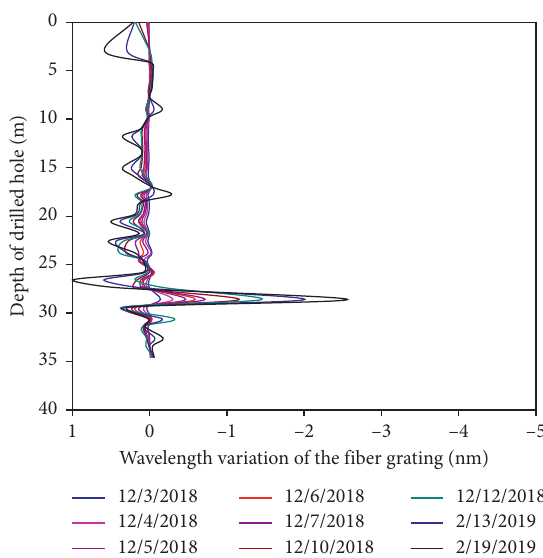
Figure 11: Wavelength of fiber grating at D 2.